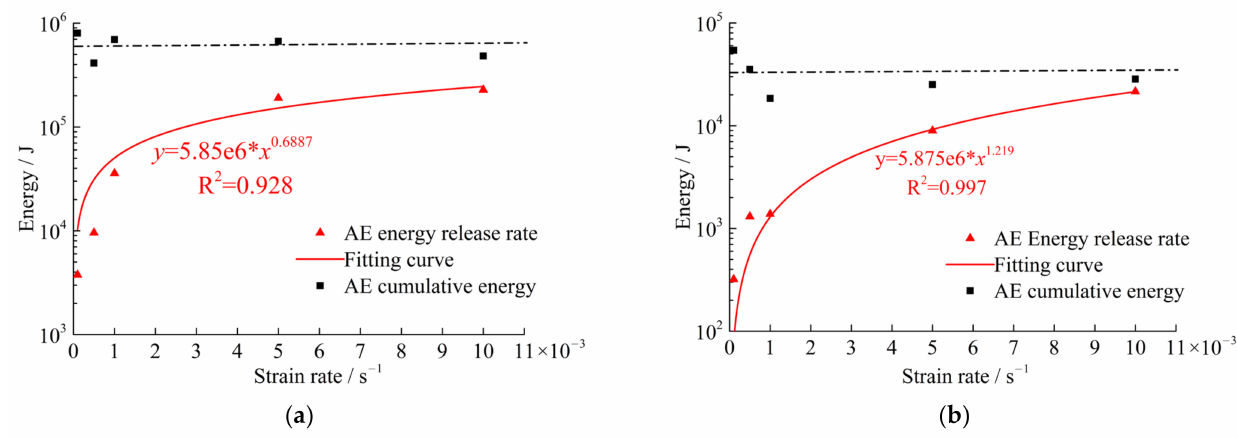
Figure 13. Energy evolution at different strain rates: ( a ) Horizontal bedding; and ( b ) Vertical